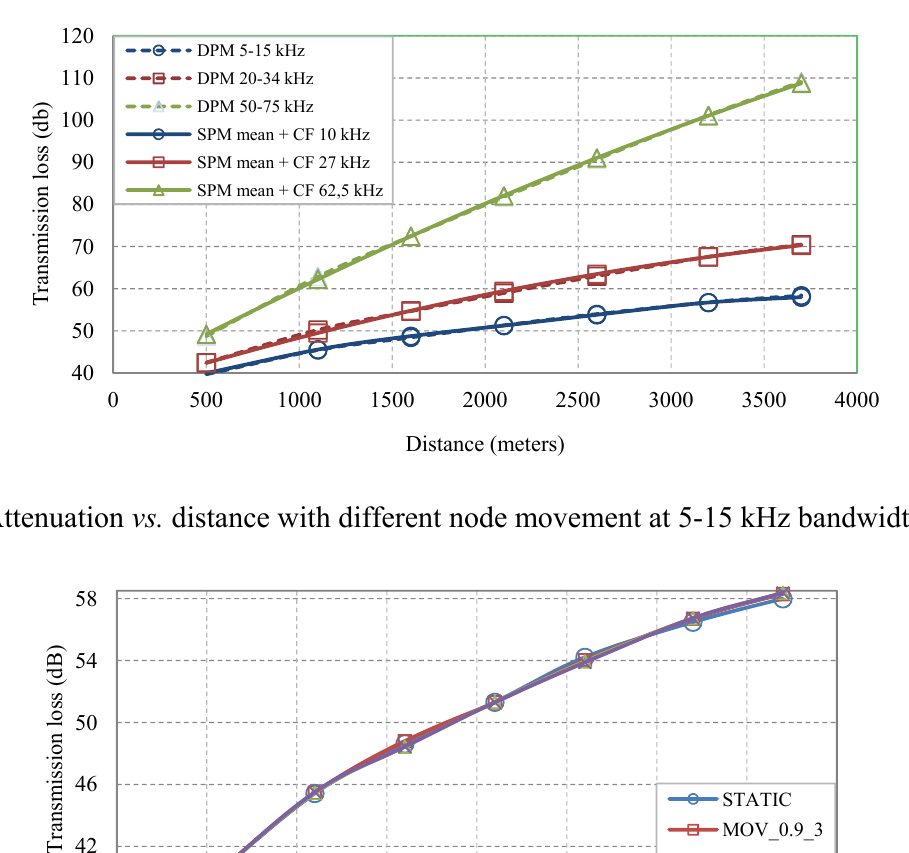
Figure 7. Bandwidth signals loss with DPM and SPM single frequency proposal after applying the bandwidth correction factor.